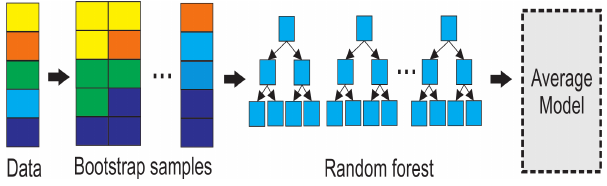
Fig 14. Many single decision trees are built that will work with random data from a dataset. Thus, the results of object prediction were aggregated based on the majority rule from these trees.